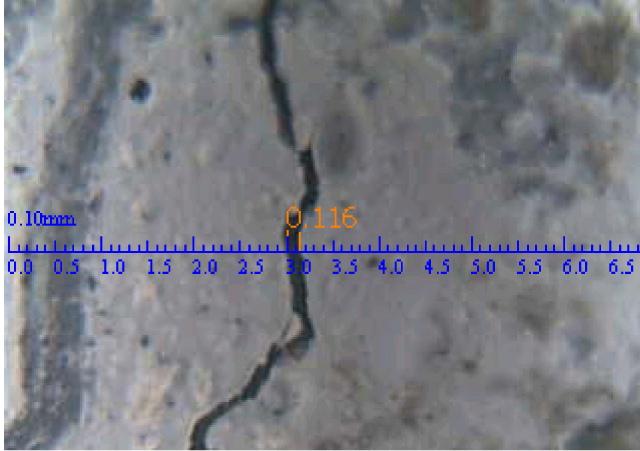
Figure 7. Typical crack width measurement result (unit: